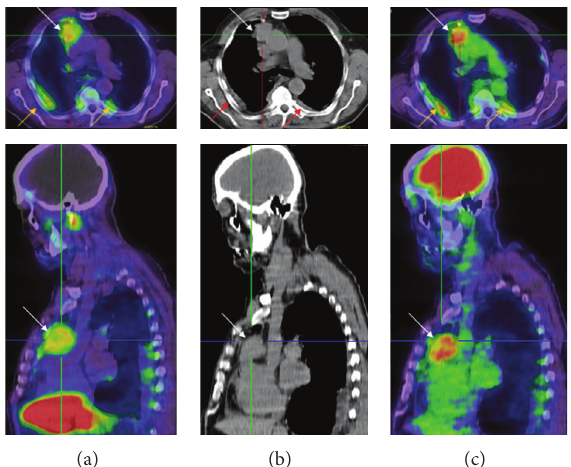
Figure 1: A 78-year-old male patient with biopsy confirmed thymic carcinoma. A comparison model between 18 F-FECH-PET and 18 F-FDG-PET. 18 F-FECH-PET/CT fused imaging (a), 18 F-FDG- PET/CT fused imaging (c) and matching CT imaging (b). Axial planes (upper row) and sagittal planes (lower row). The images demonstrate a thymic carcinoma in anterior mediastinum (white arrows) with pleural involvement (red arrows). We note a superior tumor-to-background ratio in 18 F-FECH-PET/CT imaging in com- parison to 18 F-FDG-PET/CT